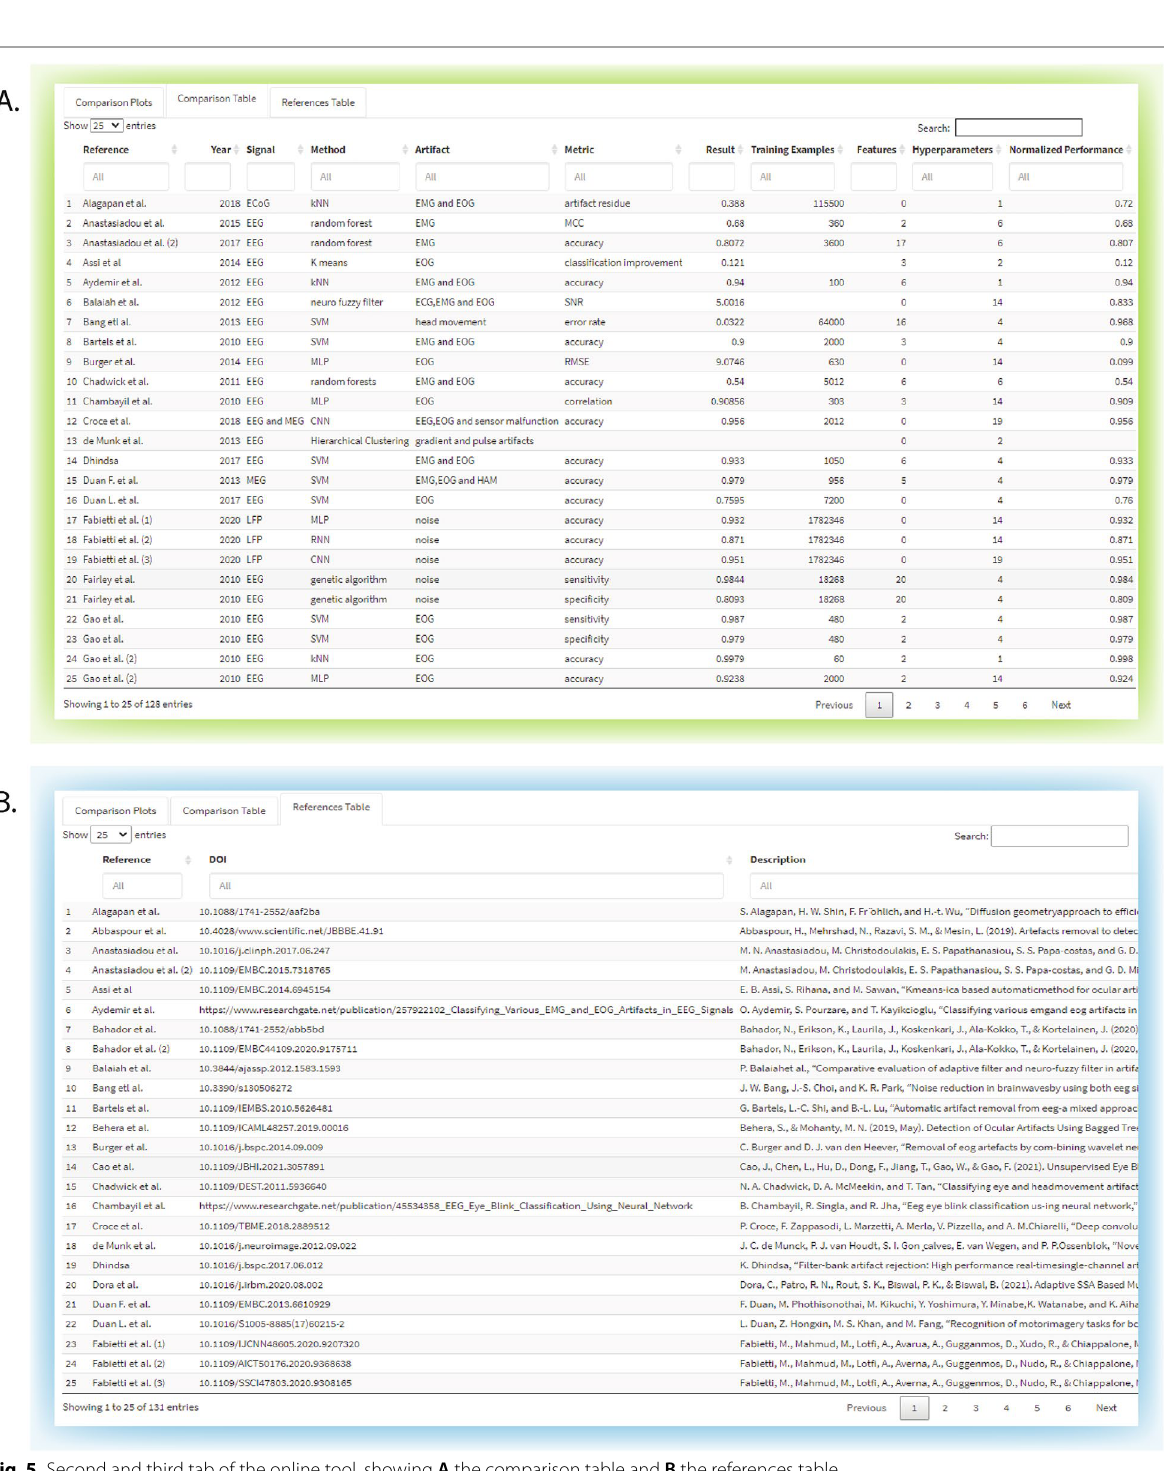
Fig. 5 Second and third tab of the online tool, showing A the comparison table and B the references